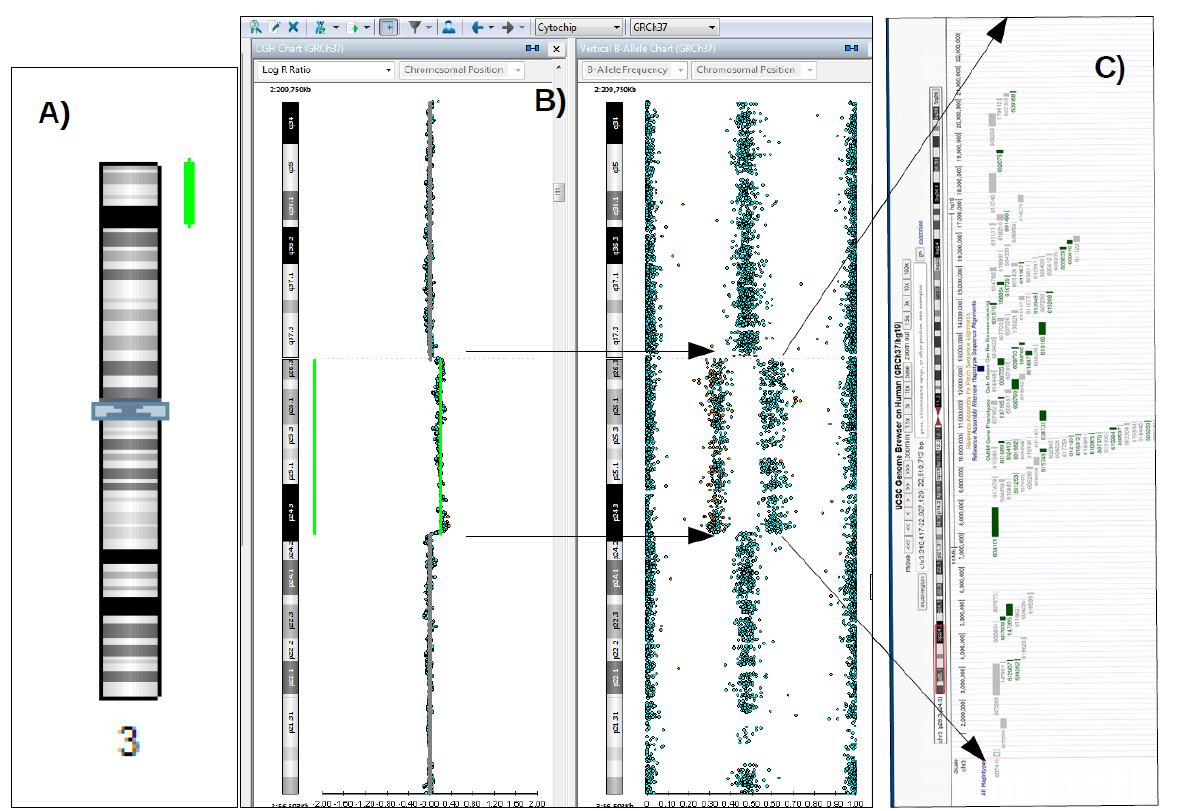
Figure 1. Pathogenic duplication of 22.5 Mb in 3p26.3p24.3 region detected by SNP-Array (green lines in “( A , B )” in a five-year-old patient, with delay of psycho-motor development, bilateral fronto-parietal lysencephaly, and pachygyria. SNP-Array methodology: the DNA sample isolated from peripheral blood was analyzed with the HumanCytoSNP-12 v2.1 Analysis BeadChip Kit (Illumina). The scanning was performed with the NextSeq550 equipment and the software related to the equipment (Illumina). Data analysis was performed with BlueFuse Multi 4.5 Software (32178) (Illumina), using the databases: UCSC Genome Browser, DECIPHER, OMIM, ISCA, DGV, ClinGen and ClinVar. The patient is a female child of healthy non-consanguineous parents. There is no family history of developmental delay. Molecular karyotype formula (according to ISCN 2016): arr[GRCh37]3p26.3p24.3(316417-22827129)x3,4q34.3q35.2(182338549-190880409)x1; “ ( C ) ” Schematic representation of genes localized in the duplicated region 3p26.3p24.3, located in the red rectangle on the schematized chromosome 3 (from UCSC browser). Each rectangle represents an OMIM gene, those colored in green are genes with known involvement in pathogenesis. The 22.5 Mb duplication detected in the 3p26.3p24.3 region contains 80 OMIM genes, many of them being candidate or asso- ciated with pathogenesis, such as the SETD5 gene (OMIM 615743, associated with intellectual disa- bility, autosomal dominant AD 23, OMIM 615761), CRBN gene (OMIM 609262, associated with in- tellectual disability, autosomal recessive, AR, 2, OMIM 607417), CCDC174 gene (OMIM 616735, as- sociated with Hypotonia, infantile syndrome, with psychomotor inhibition, autosomal recessive AR, OMIM 616816), BRPF1 gene (OMIM 602410, associated with Intellectual developmental disor- der syndrome with dysmorphic facies and ptosis, AD, OMIM 61733), CHL1 and CNTN6 , those being ASD candidate genes, playing an important role in language and cognitive development [1,2]. More other microduplications of comparable size, with (likely) pathogenic significance, were reported in clinical databases, such as ClinVar (Variation ID: 155700, 148876, 57977) and Decipher (ID patients: 400840, 292119) in case of patients with intelectual disability, MCM (such as: tetralogy of Fallot, abnormality of the genitourinary, digestive, and/or musculoscheletal system). Additionally, 3q26 microduplication syndrome is described in Orphanet database as a syndromic form associated with prenatal and postnatal growth inhibition, developmental delay, intellectual impairment, dys- morphic signs, and variable combination of congenital anomalies, including cardiovascular, genito- urinary, and skeletal anomalies and spectrum of caudal malformations (ORPHA:96095).